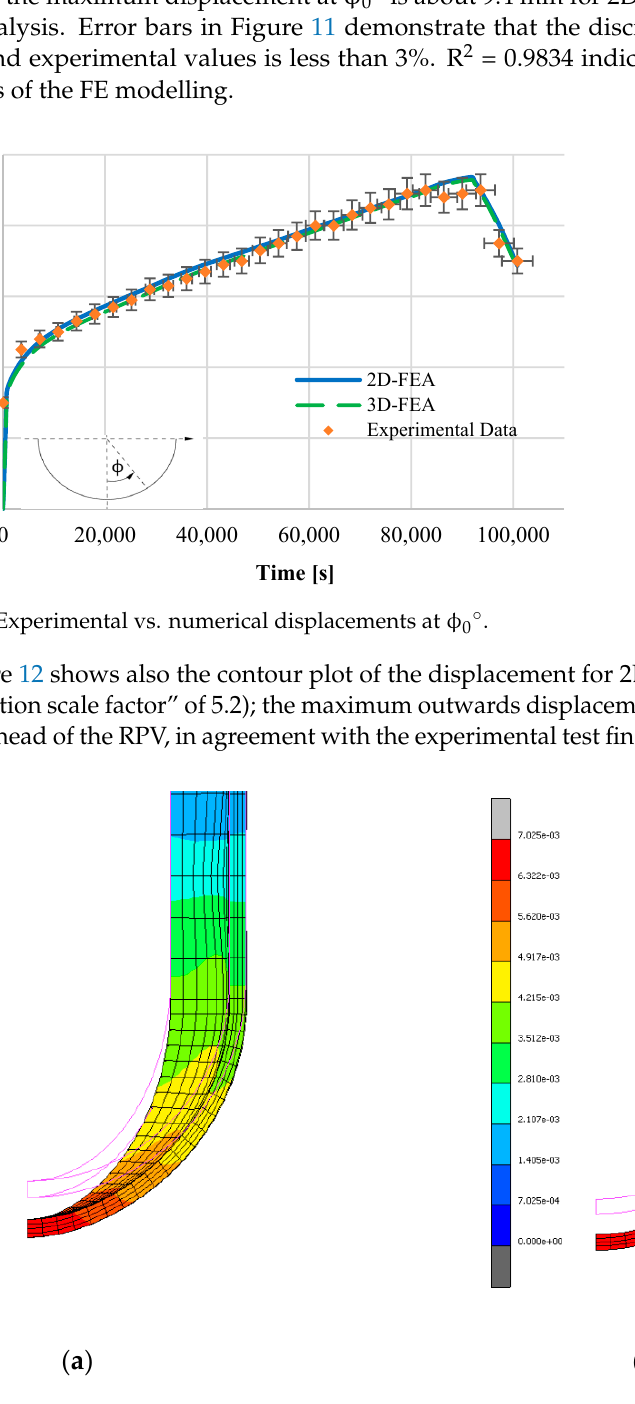
( b ) Figure 10. ( a , b ): View of a sector of 2D ( a ) and 3D ( b ) FE models. The FE-model developed (coupling between ageing degradation and viscoplastic model) was able to predict the thermo-mechanical behaviour of scaled RPV in harsh con-